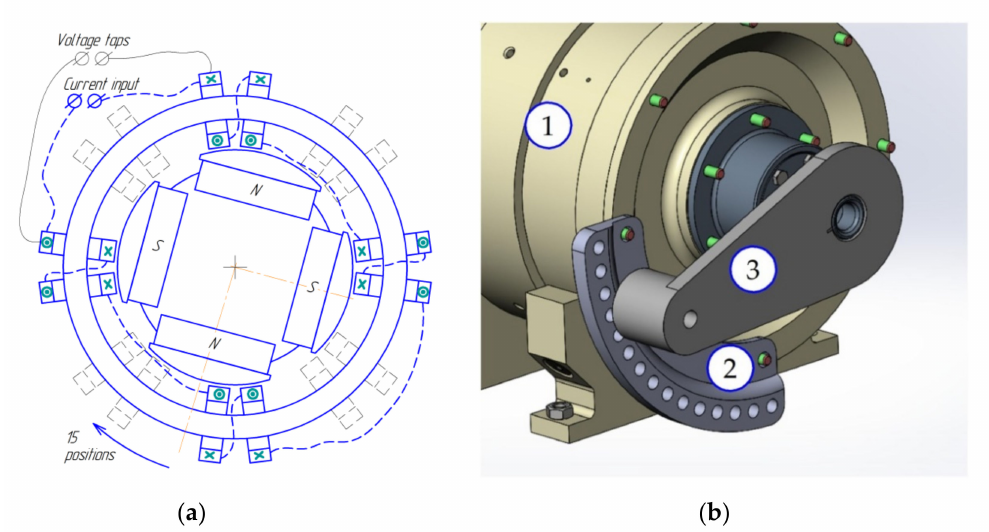
Figure 5. ( a ) Schematic representation of an annular winding with an inside-mounted rotor; ( b ) locking device for the rotor. 1—assembled machine with HTS windings, 2—fixed plank with 15 holes, and 3—“arrow” device, fixed on shaft of the